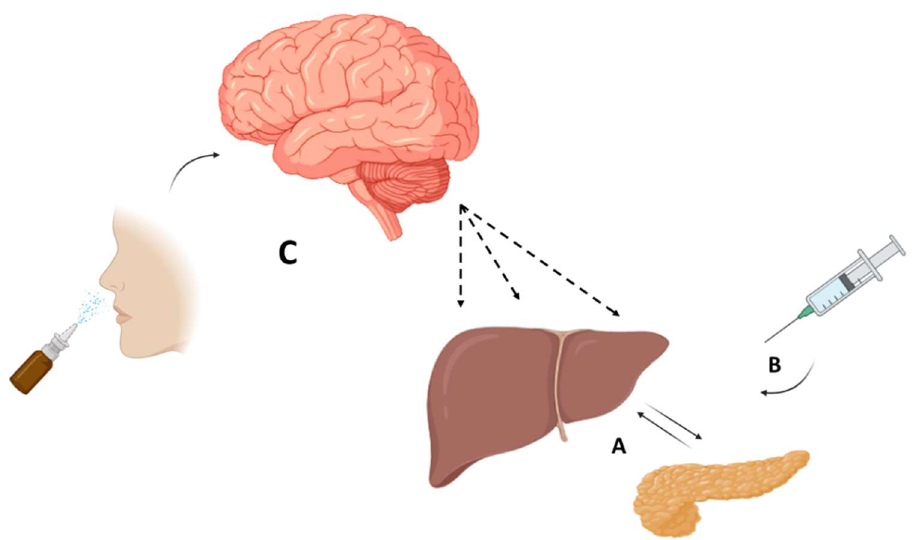
Figure 2. Hypothetical pathway of glucagon action/modulation on liver. ( A ) In physiological conditions, blood glucose regulates insulin and glucagon secretion. The equilibrium of these two hormones controls hepatic glucose release. ( B ) When glucagon is intramuscularly injected, it acts mainly at the hepatic level resulting in the activation of glucose release through glycogen lysis and gluconeogenesis. ( C ) Nasal glucagon administration could induce actions at the brain levels. In this way, novel potential actions at the hepatic level could regulate hepatic glucose release.